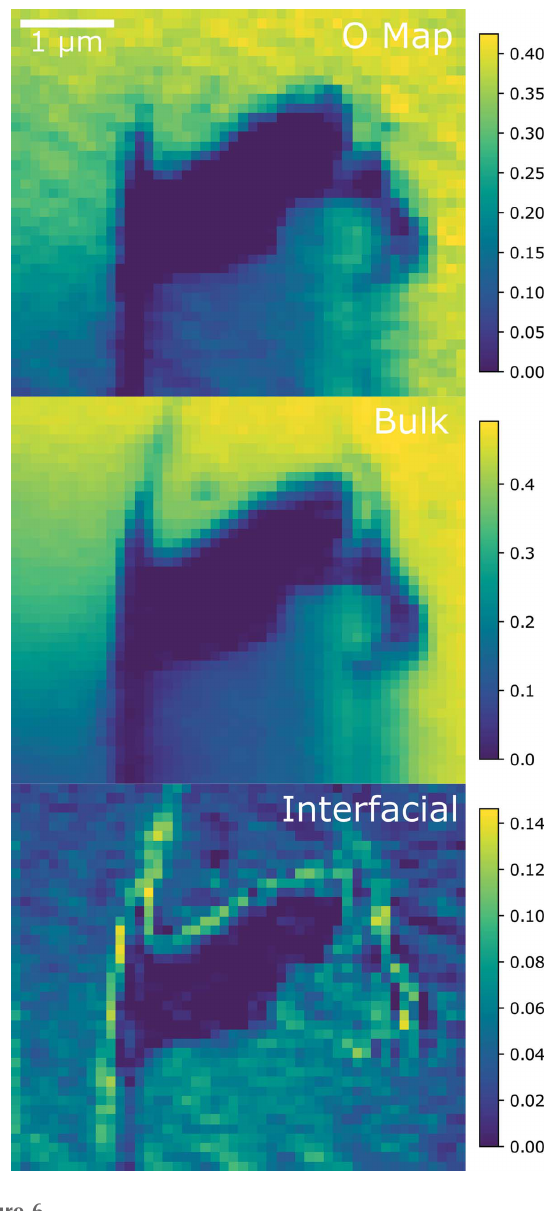
Figure 6 (Top) An oxygen map, and (middle) bulk and (bottom) interfacial species maps of FIB section 2B near a large defect in the sample, sourced from the center of the pellet. The color bars on the right-hand side indicate a quantitative measure of the oxygen content in each phase. The STXM pixel size is 100 nm (cid:3) 100